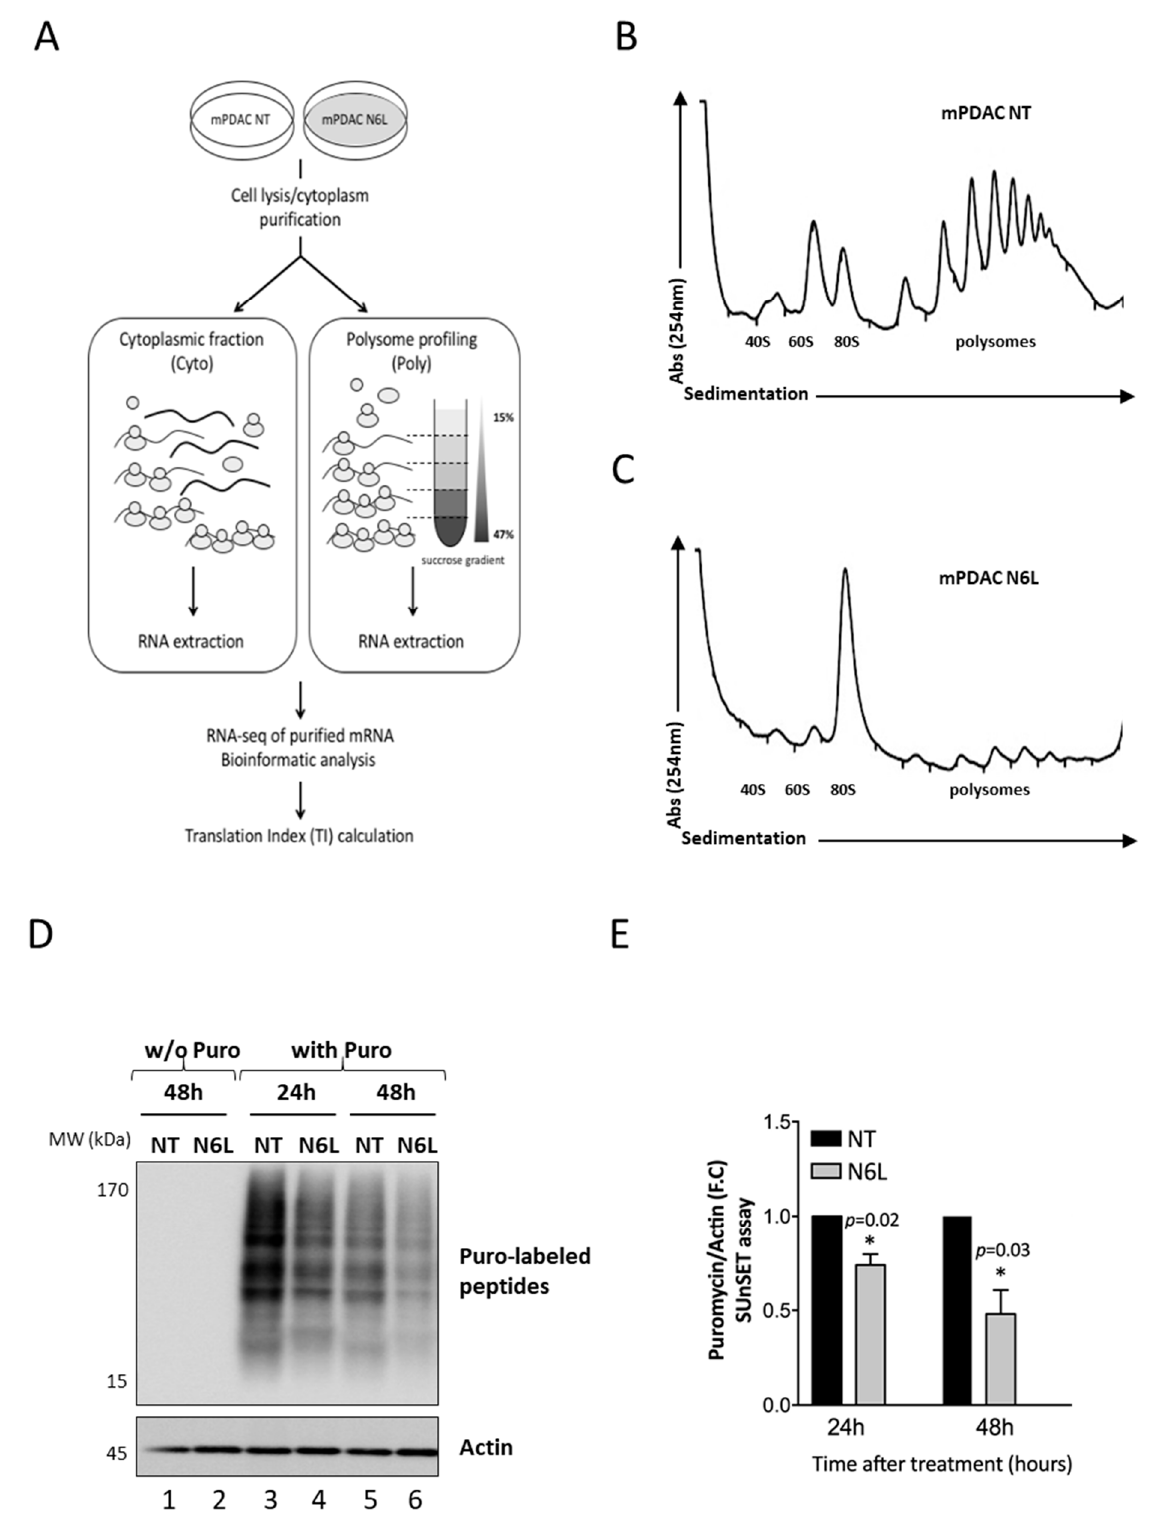
Figure 1. NCL targeting by N6L impacts mPDAC cell translation. ( A )—Experimental design of translatome analysis procedure. mPDAC cells were treated (T) or not (NT) with 50 µ M of N6L for 48 h. Cytosolic lysates from cells were sedimented on a sucrose gradient (15–47%). Following ultracentrifugation, 40S and 60S ribosome subunits, the 80S monosomes, and polysomes are separated. RNAs were extracted from polysome pooled fractions (mRNA-associated polysomes) and cytoplasmic fractions (cytoplasmic mRNA). The RNA quality and integrity were verified using a Bioanalyser 2100 before sequencing and bioinformatics analysis. B,C —Polysome profiles of mPDAC cells non-treated (mPDAC NT) or treated